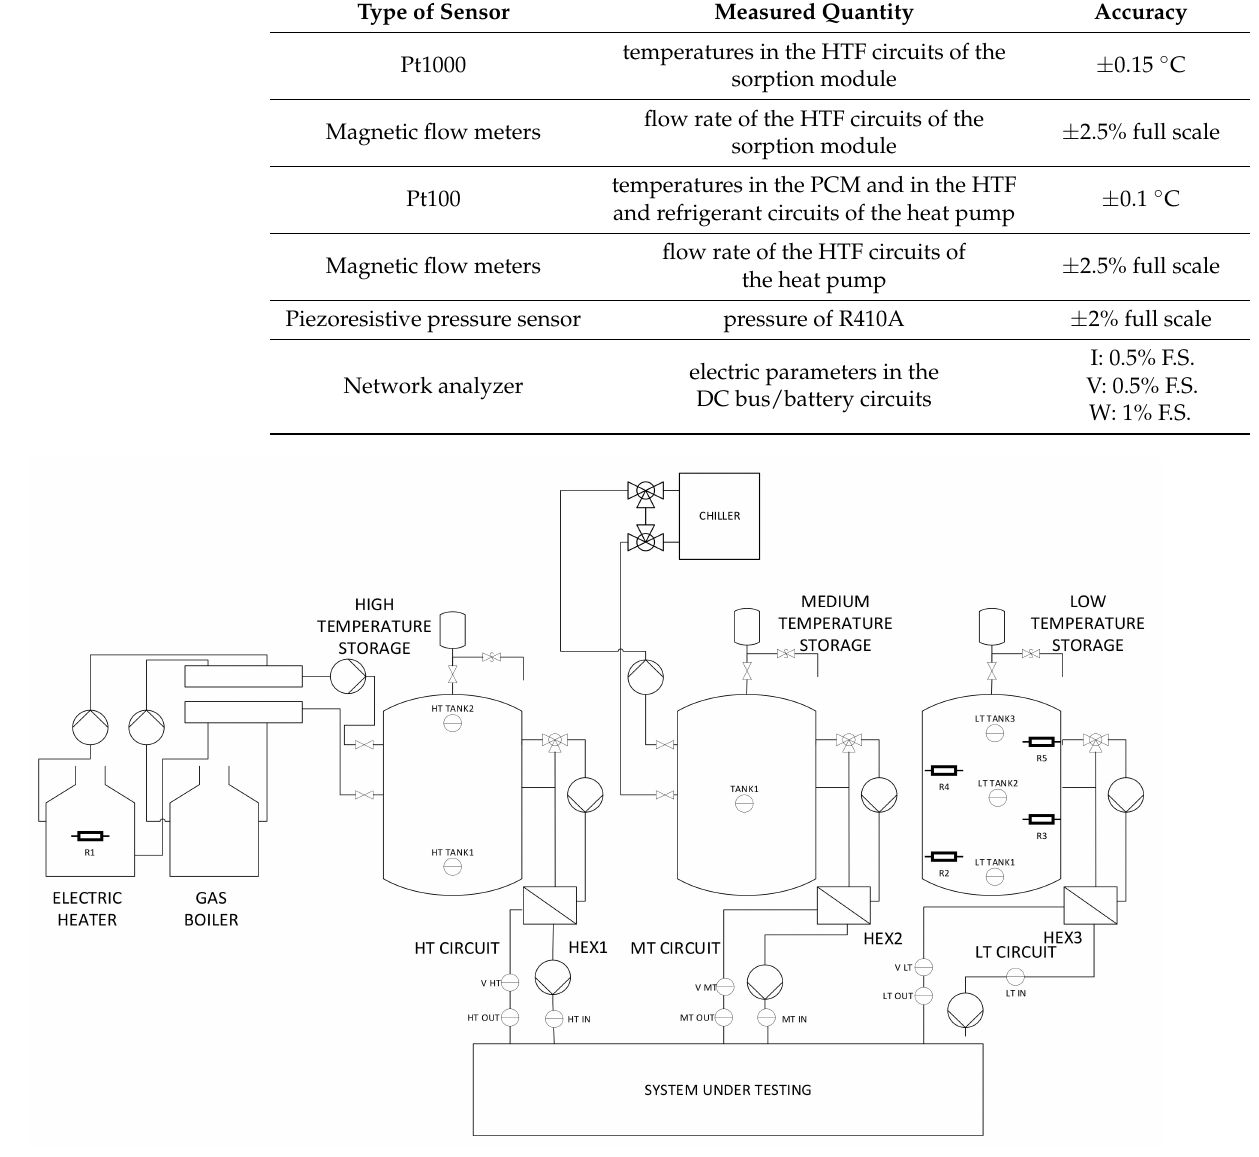
Figure 3. Layout of the test stand at CNR and main